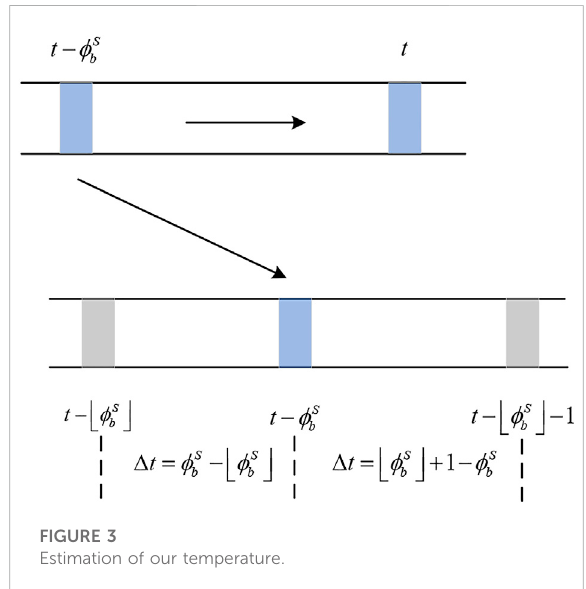
FIGURE 3 Estimation of our temperature.